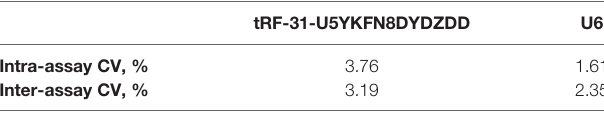
TABLE 1 | The intra-assay coef fi cient of variation and the inter-assay coef fi cient of variation of tRF-31-U5YKFN8DYDZDD.